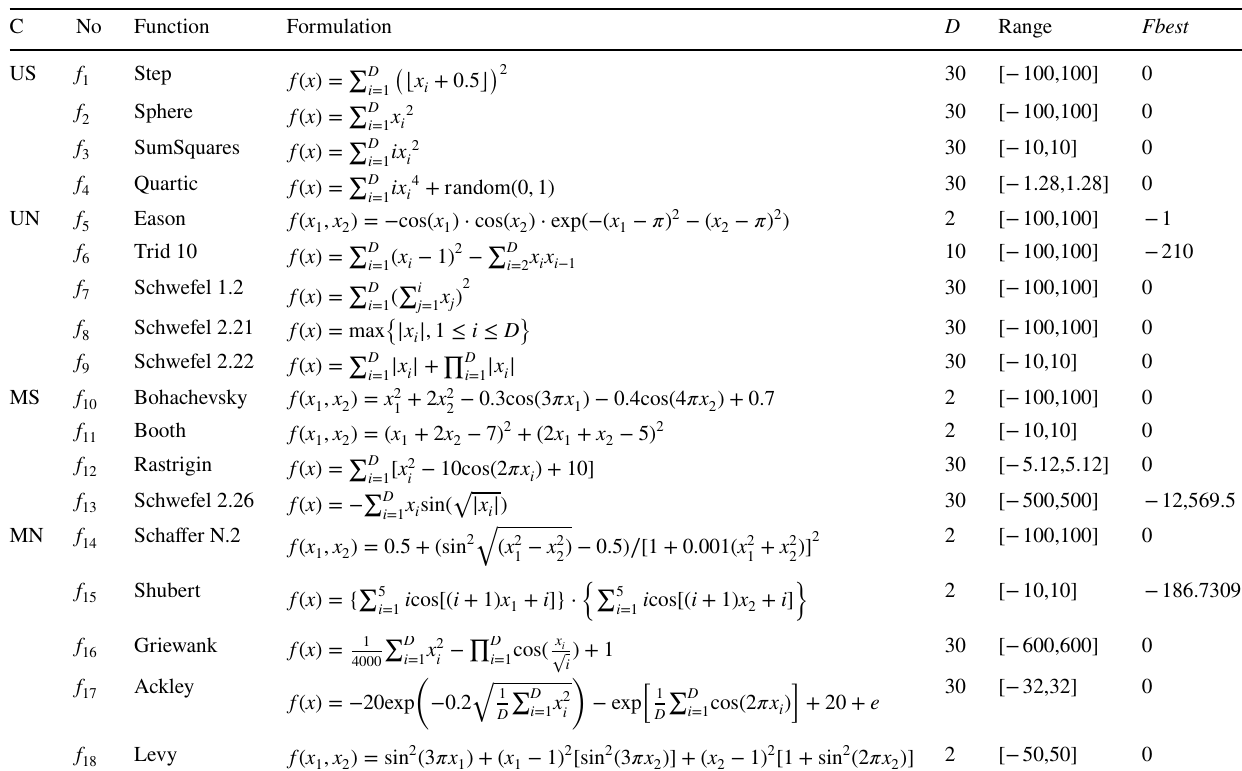
Table 3 18 benchmark